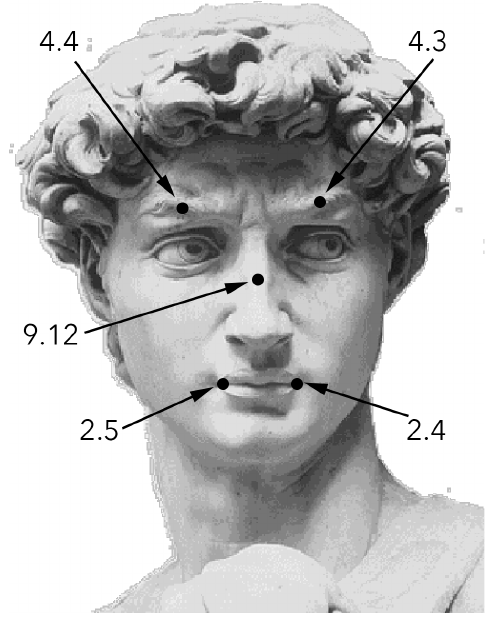
Figure 2. Configuration of the used facial feature points